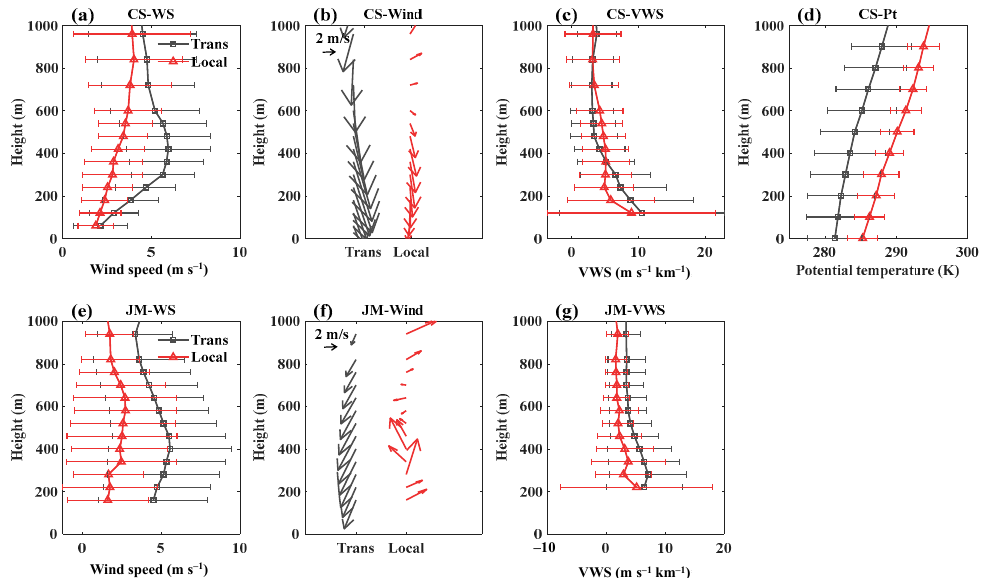
Figure 11. Vertical profiles of ( a , e ) wind speed, ( b , f ) wind, ( c , g ) VWS, and ( d ) potential temperature averaged in the transport-type and local-type heavy pollution days in ( a – d ) CS and ( e – g ) JM. Error bars denote the standard